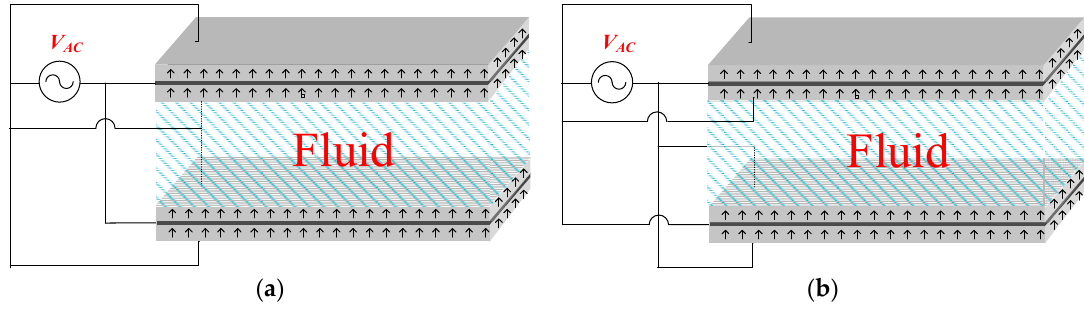
Figure 7. Configuration in electrical connections of dual piezoelectric bimorphs to drive in ( a ) anti-phase motion and ( b ) in-phase motion.